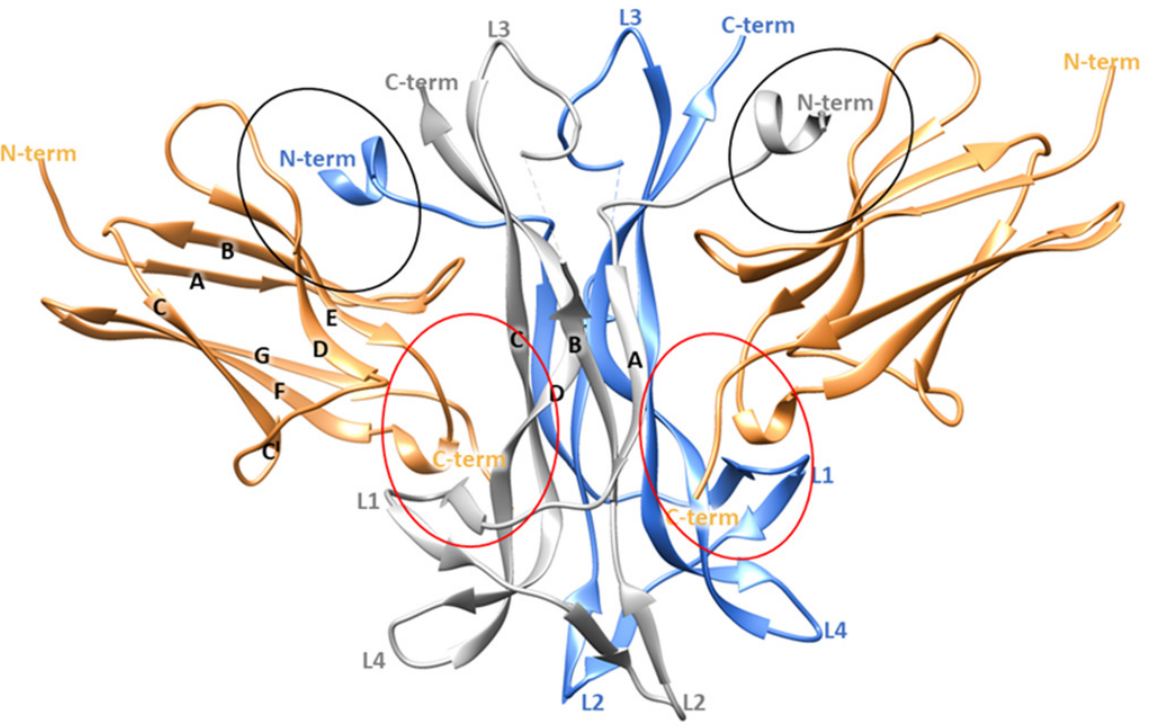
Figure 1. Crystallographic structure of TrkA-NGF complex (PDB ID 1WWW). The two NGF monomers are depicted as grey and blue ribbons while the domain 5 of TrkA is represented as sand-colored ribbons. The specific and the conserved patches are highlighted by red and black circles, respectively. The image was generated by using Chimera software V1.16 (Resource for Biocomputing, Visualization, and Informatics, University of California, San Francisco, CA, USA)